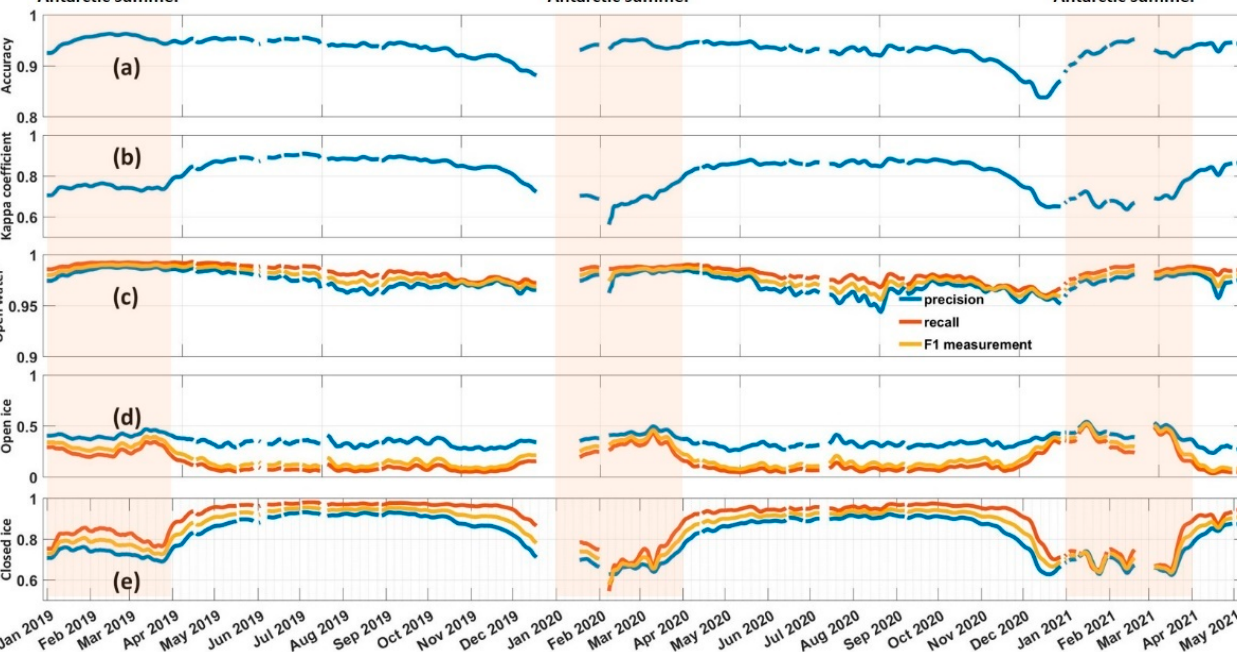
Figure 9. The time series of the evaluation parameters of the sea ice monitoring training model in the Antarctic from 1 January 2019 through 10 May 2021 for ( a ) the overall accuracy, ( b ) kappa coefficient, ( c ) open water, ( d ) open ice, and ( e ) closed ice, respectively.